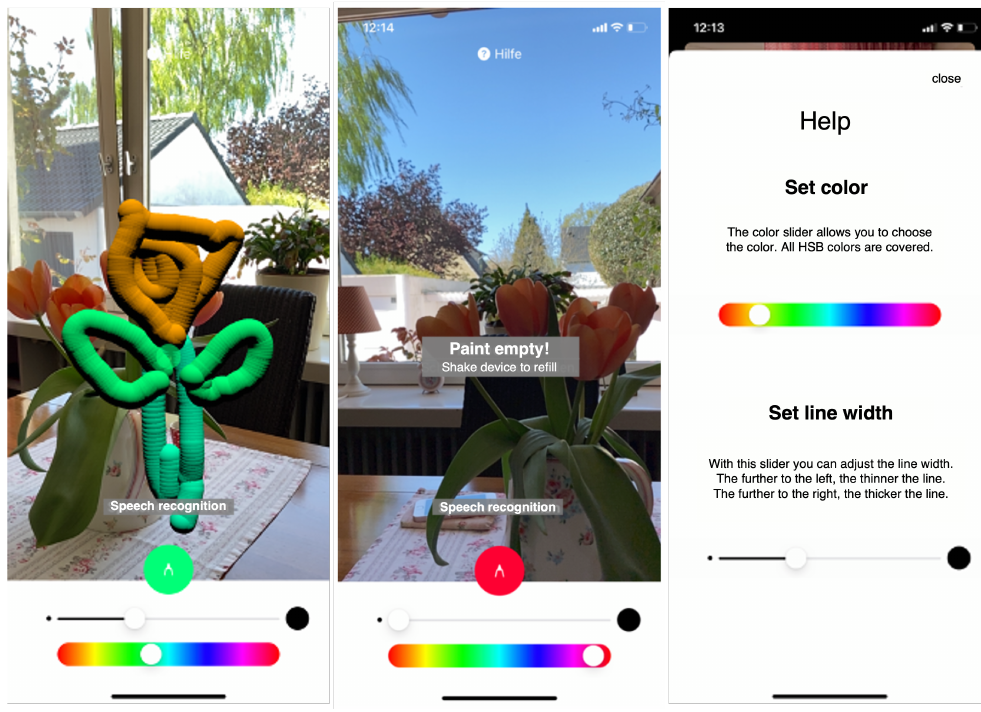
Figure 1. ARScribble